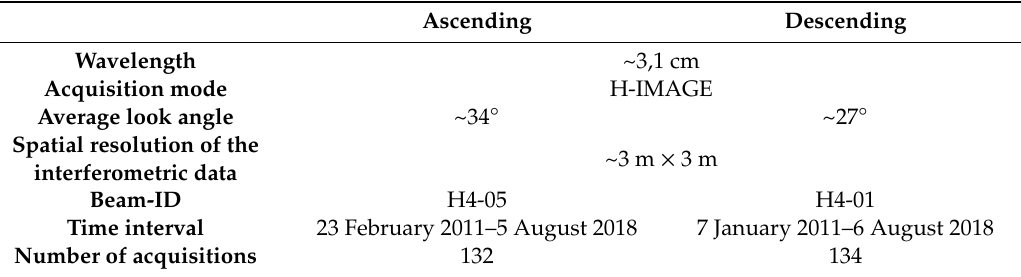
Figure 1. Representation of the two exploited COSMO-SkyMed (CSK) frames acquired from ascending (black rectangle) and descending (red rectangle) orbits, superimposed on a Google Earth optical image. Note that the white rectangle falling within the two frames represents the area of interest surrounding the Polcevera viaduct close to the Morandi bridge. Table 1. Main characteristics of the exploited CSK datasets.